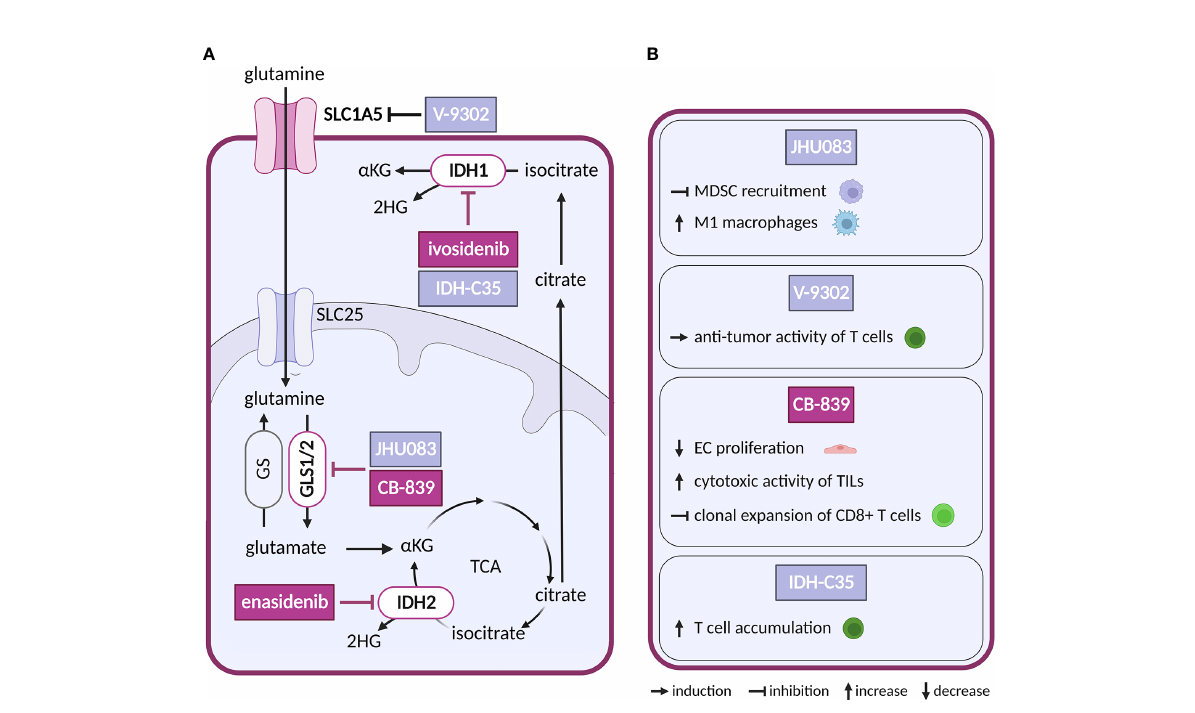
FIGURE 4 Inhibitors of glutaminolysis or IDH1/2, and their effects on TME cell types. (A) Schematic representation of glutaminolysis and IDH1/2 reactions. Inhibitors of glutamine metabolism with a reported effect in the TME and all inhibitors of IDH1 and IDH2 mentioned in the text are shown. Inhibitors tested in clinical trials for cancer are highlighted in dark violet, while those tested in preclinical studies are shown in light grey-blue. (B) Effects of the glutamine metabolism inhibitors and IDH-C35 shown in (A) on cell populations present in the